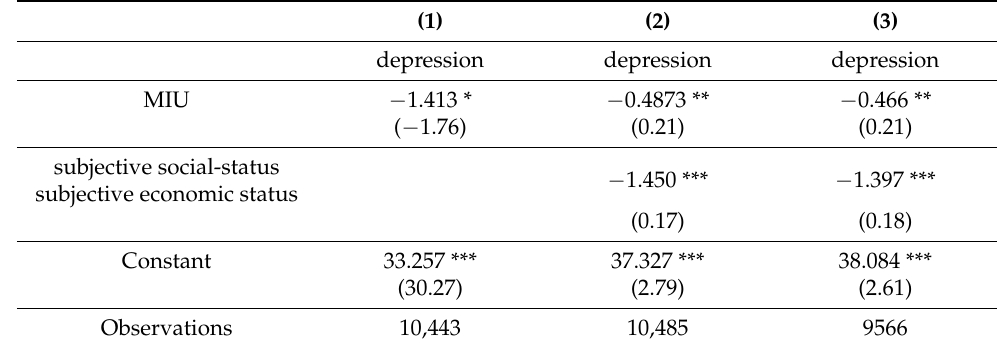
Table 15. Mediation effect